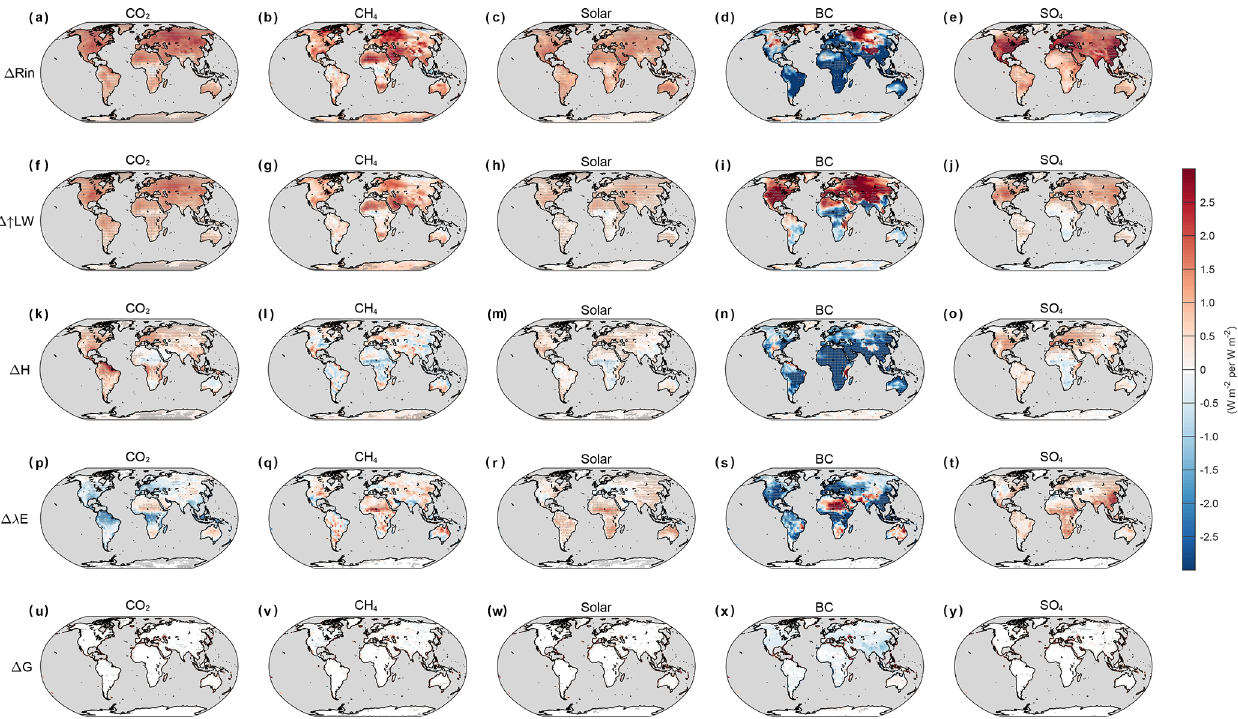
Figure 3. MMM changes of R in and outgoing energy components for all five experiments in the fsst simulations. All changes are normalized to changes per unit of global forcing. Grey dots indicate that the MMM changes are significant at a p value of